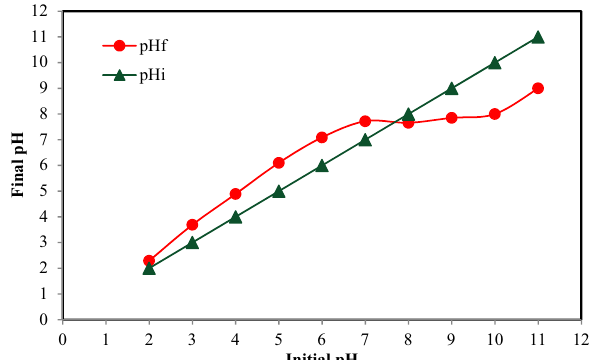
Figure 2. pH pzc of the synthesized adsorbent.